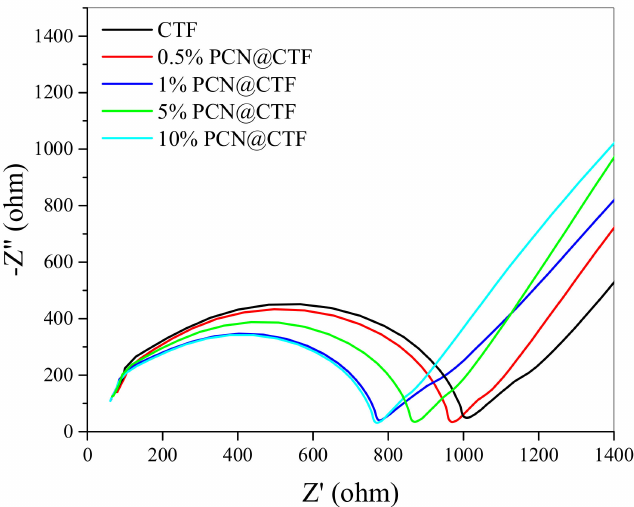
Figure 9. EIS Nyquist plots measured under an open-circuit potential of 5 mV for CTF and x